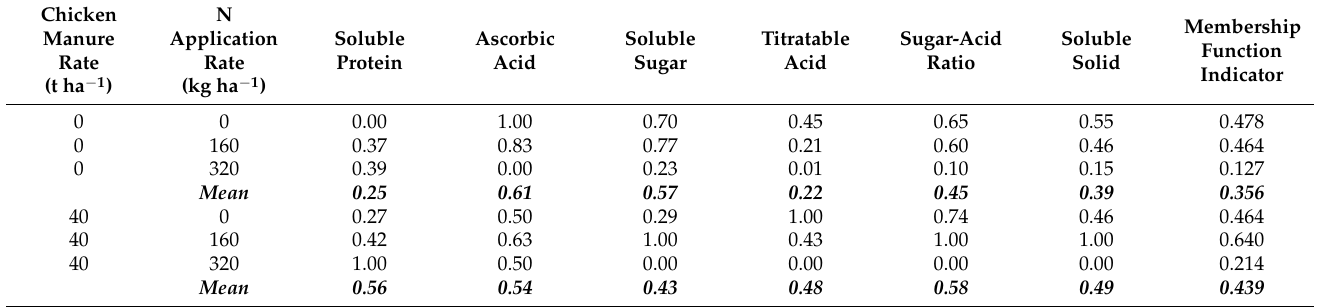
Table 2. The membership function indicator of cherry tomato under the three N rates (0, 160,